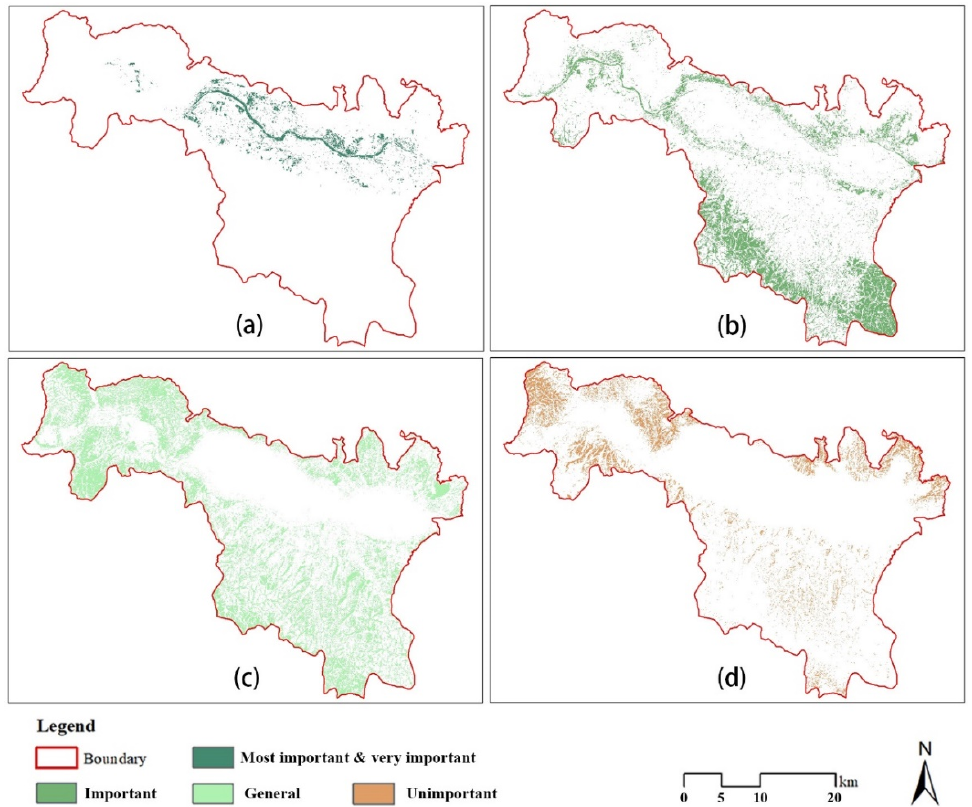
Figure 4. Distribution of: ( a ) the most important and very important , ( b ) important , ( c ) generally important , and ( d ) unimportant ecological land.